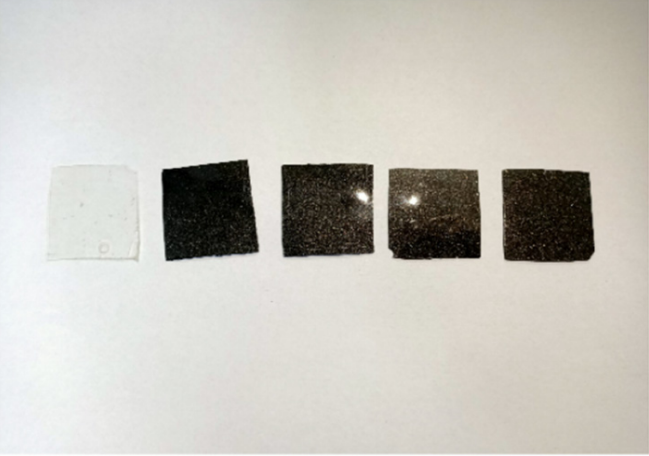
Figure 9. WM films at different MG dosages. The thermal conductivity analysis of the WM is presented in Figure